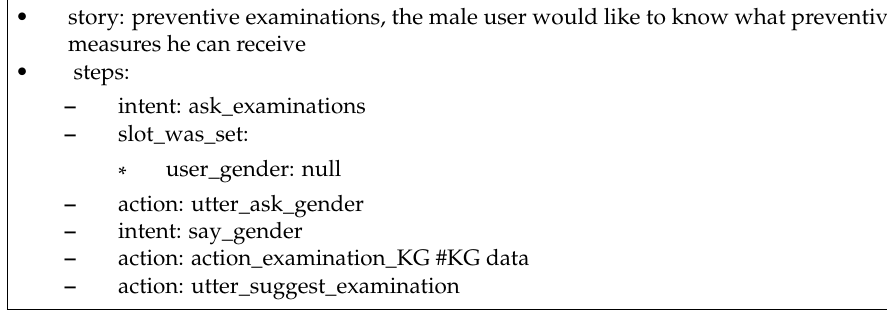
Figure 6. Rasa story: preventive